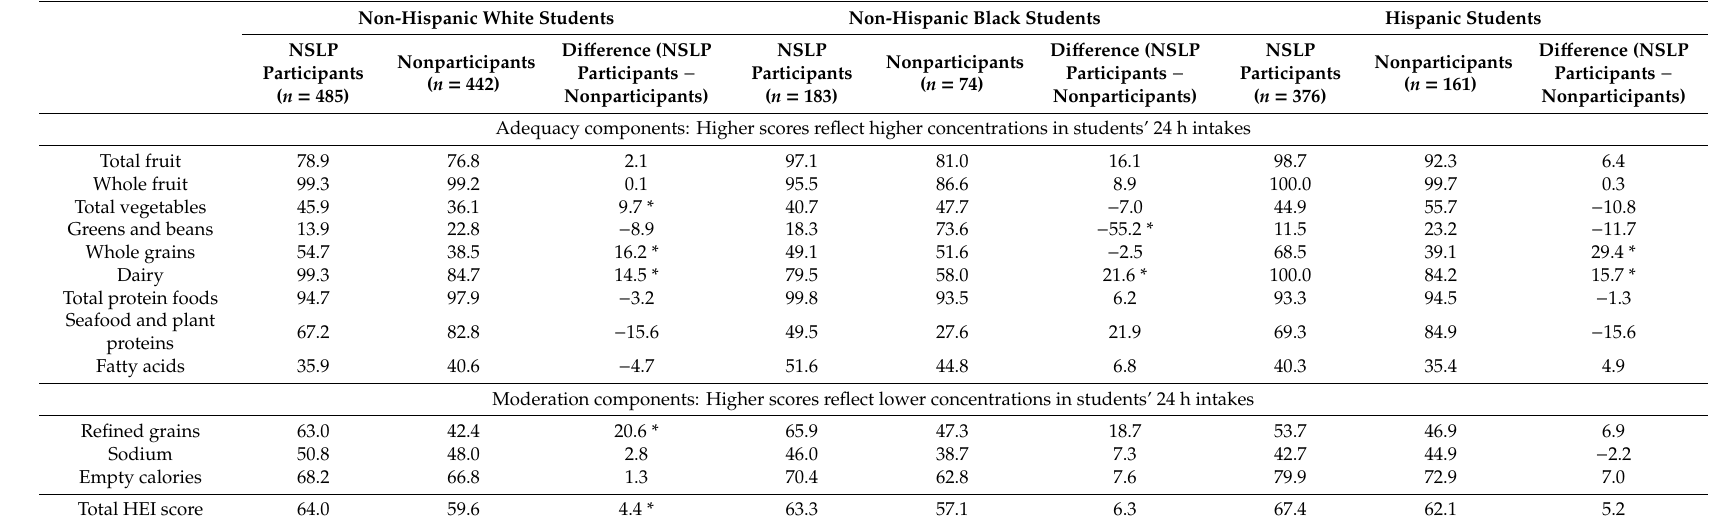
Table 6. Di ff erences between NSLP participants and nonparticipants in mean HEI-2010 scores for 24 h intakes, by race /